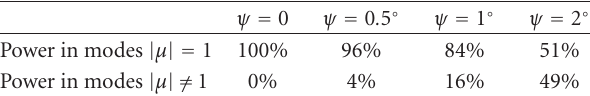
Table 1: Probe-mode power spectrum.